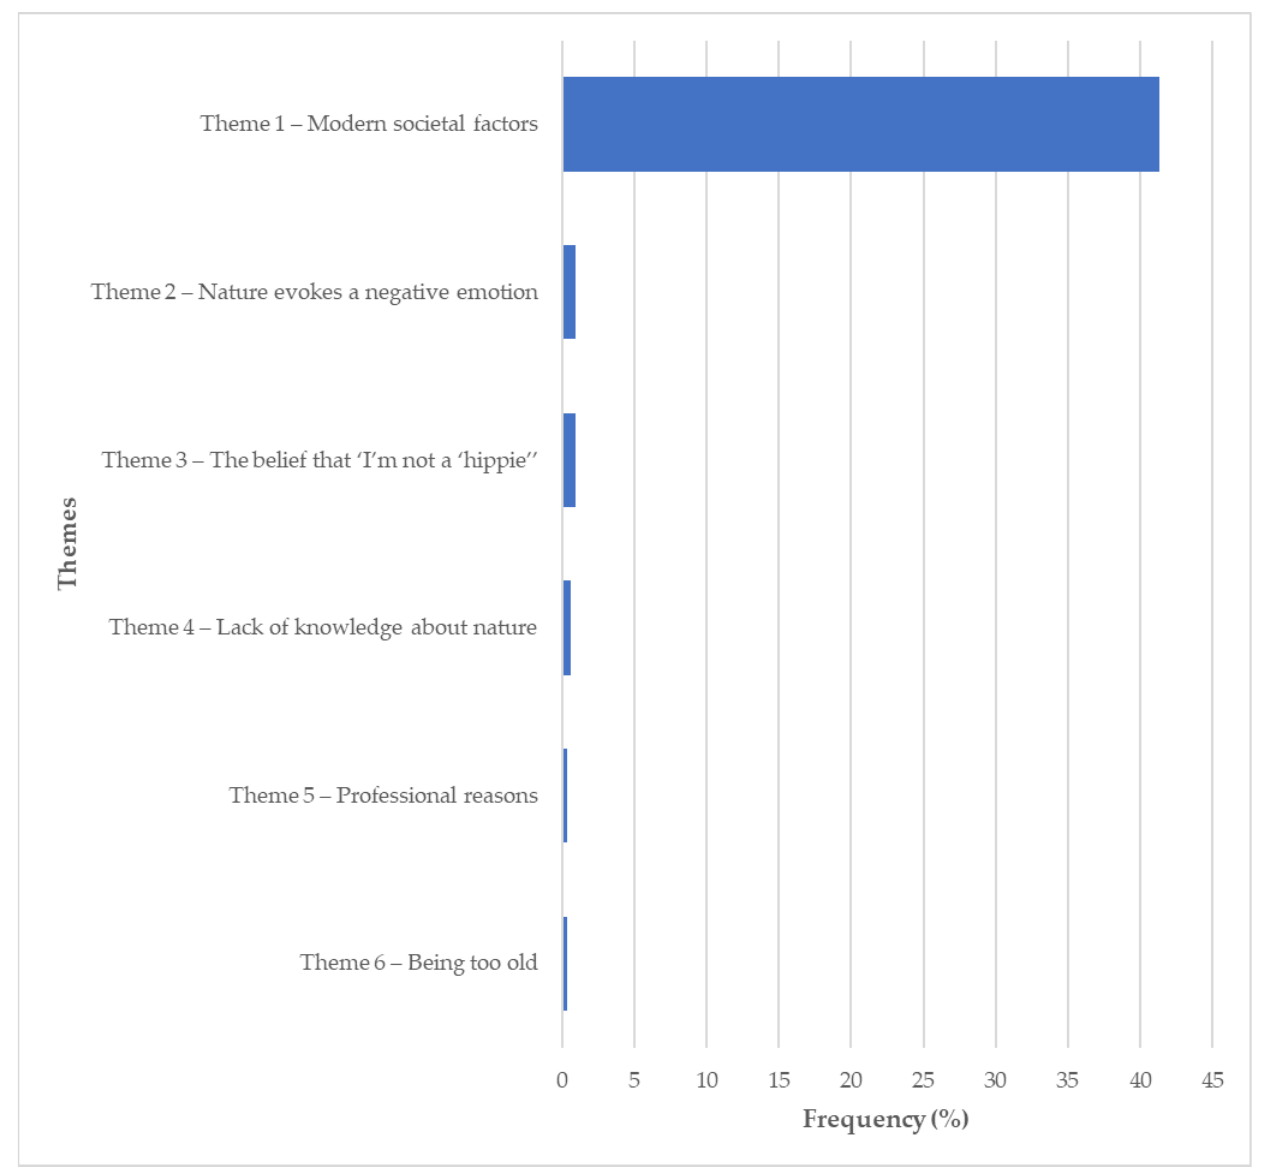
Figure 2. Perceived barriers to the connections to nature.